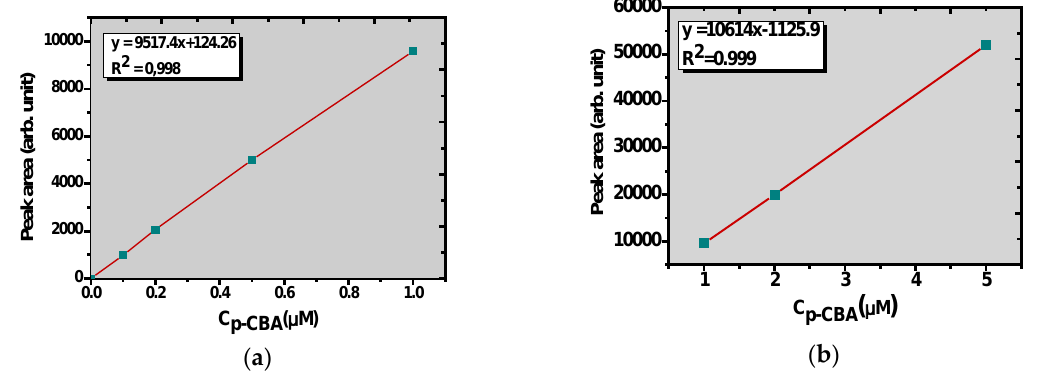
Figure 1. p‐CBA calibration curves at different concentration ranges; ( a ) 0–1 μM, and ( b ) 1–5 μM. Figure 1. p-CBA calibration curves at different concentration ranges; ( a ) 0–1 µ M, and ( b ) 1–5 µ